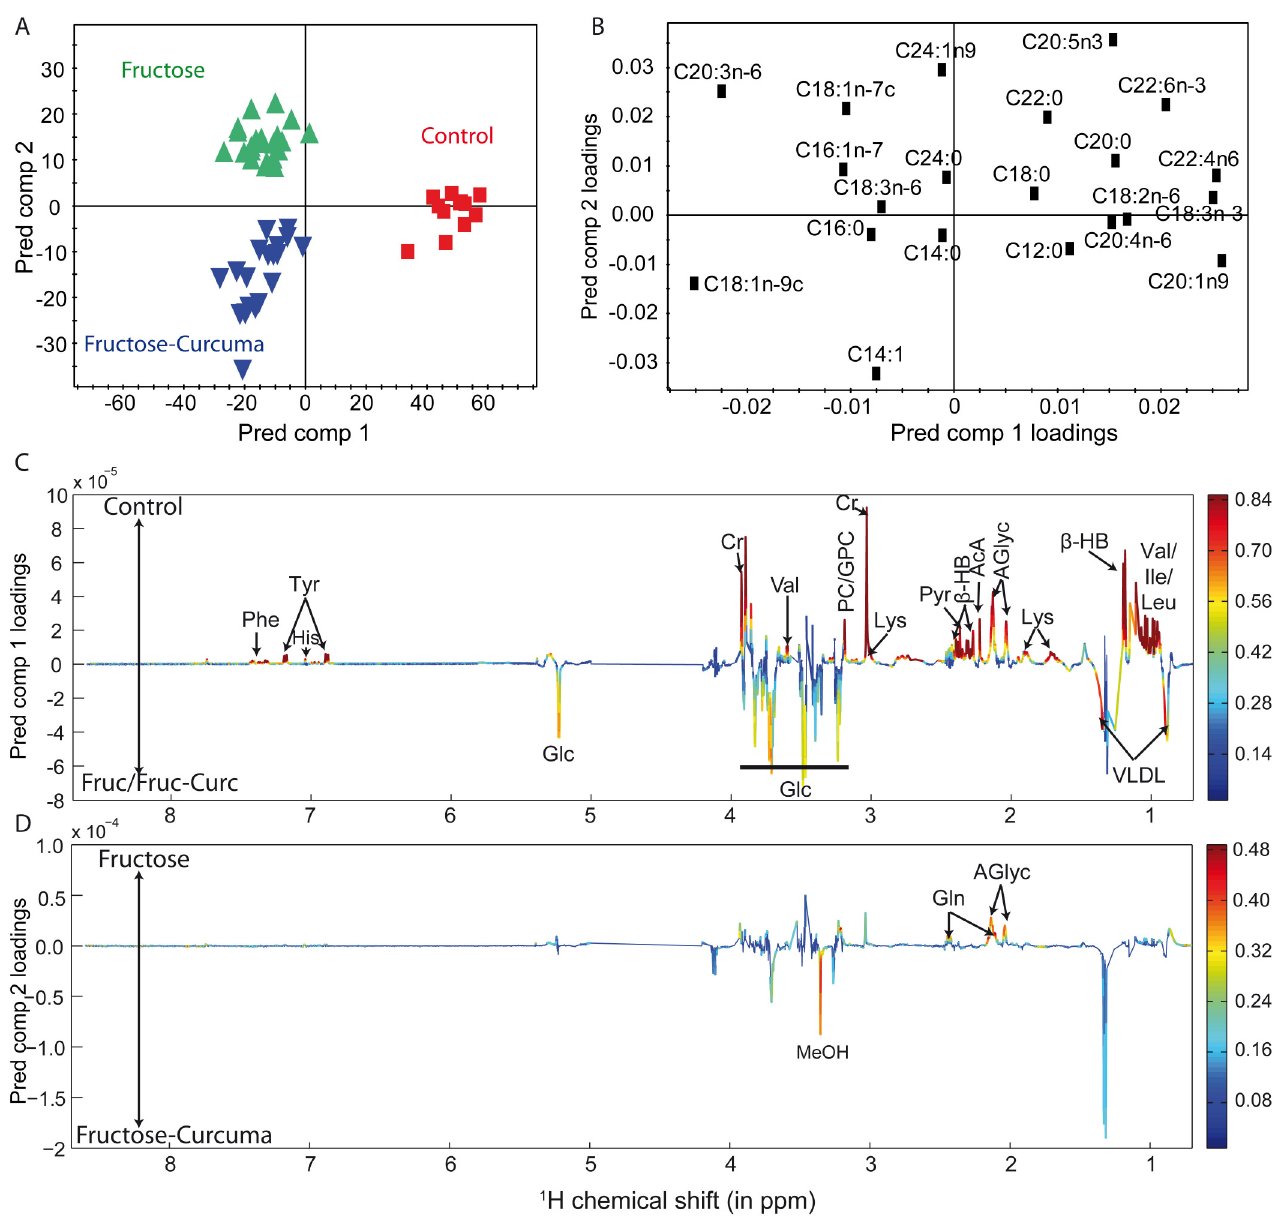
Fig 3. OPLS-DA score and loadings plots. (A) OPLS-DA score plot representing the 54 samples in the Tpred 1 vs Tpred 2 plane. (B, C-D) OPLSDA loadings plot representing the weights of the relative fatty acid contents and the NMR signals, respectively, along the two predictive components derived from OPLS-DA model of serum samples obtained from controls, HFS and HFS+C groups. The line variation (C, D) corresponds to model covariance derived from the mean-centered model, whereas the color map corresponds to model correlation derived from the unit-variance